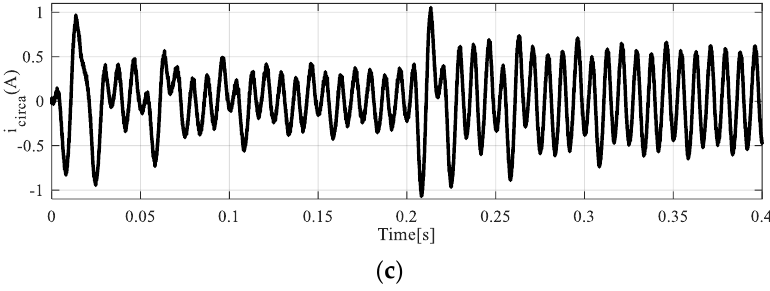
Figure 15. The circulating currents of phase “a” for the ( a ) first controller, ( b ) second controller, and ( c ) third controller.